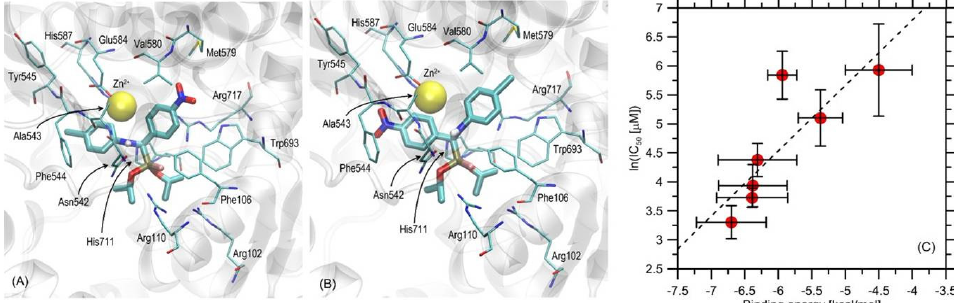
Figure 7. ( A , B ). Location of the ligand molecule (two stereoisomers of compound 4 ) bound to protein (PDB: 6thp). The ligand molecule is shown as thick stick representation, whereas all the closest amino-acid residues are represented by thin sticks. The Zn 2+ ion is represented by the yellow ball. ( C ) Correlation between the theoretical ligand–protein binding energies and the experimentallydetermined values of IC50. Horizontal error bars correspond to the standard deviations of binding energies obtained from the complete set of the lowestenergy ligand–protein structures.